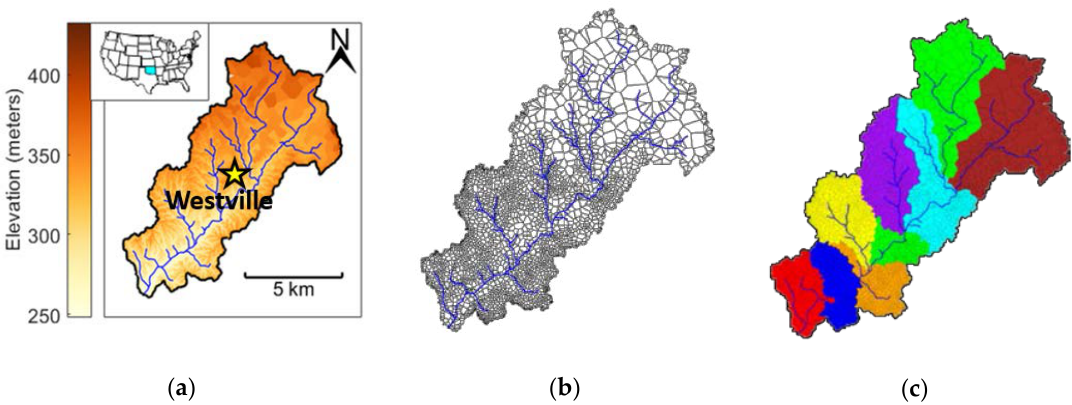
Figure 3. Case study and model setup. ( a ) Basin location, elevation, and drainage network. (b ) Discretization of the basin into Voronoi polygons for triangulated irregular network real-time integrated basin simulator (tRIBS). ( c ) Partitioning of the basin for parallel computation using eight processors.